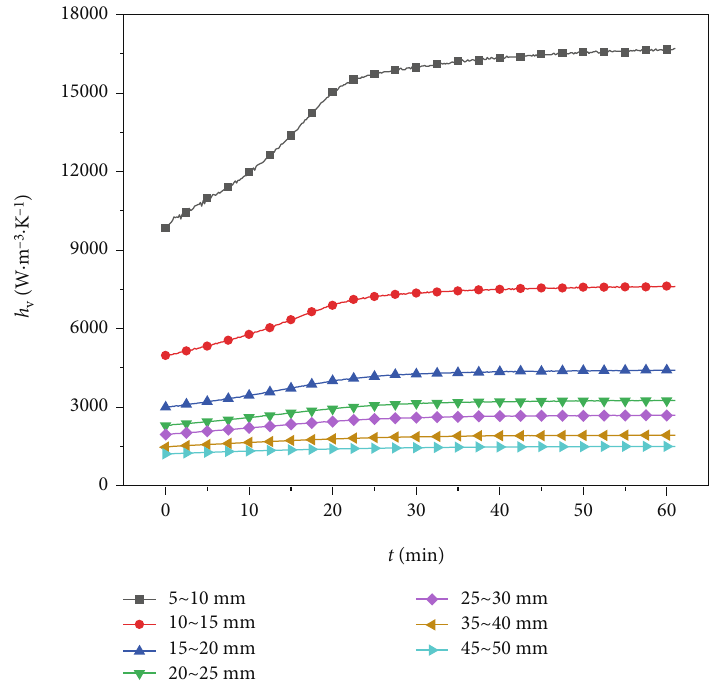
Figure 17: Variation of the volumetric heat transfer coe ffi cient h of 0.8m · s -1 .